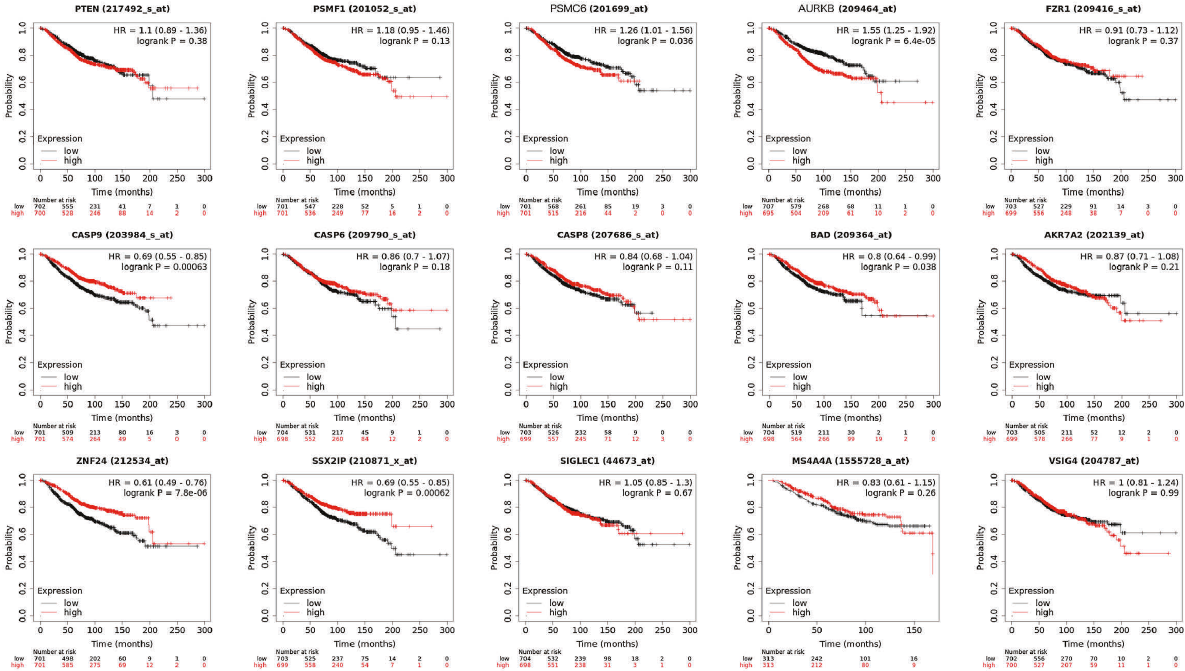
Figure 4: Survival analyses for fifteen hub genes in breast cancer patients. Survival curves show that the expression of PSMC6, AURKB, CASP9, BAD, ZNF24, and SSX2IP was associated with a worse overall survival rate ( P < 0 . 05). Table 3: The10 most significant small molecule drugs for Inflammatory breast